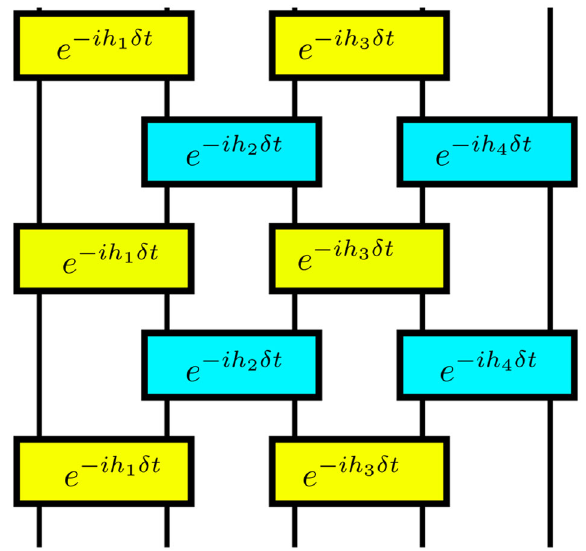
Fig. 1 Implementation of product formula on quantum circuits. A simple illustration of quantum simulation using product formula. Here H = h 1 + h 2 + h 3 + h 4 . We decompose the local terms into two layers H A = h 1 + h 3 and H B = h 2 + h 4 . Because the local terms in each layer all commute with each other, there ’ s no problem in constructing the circuit with local